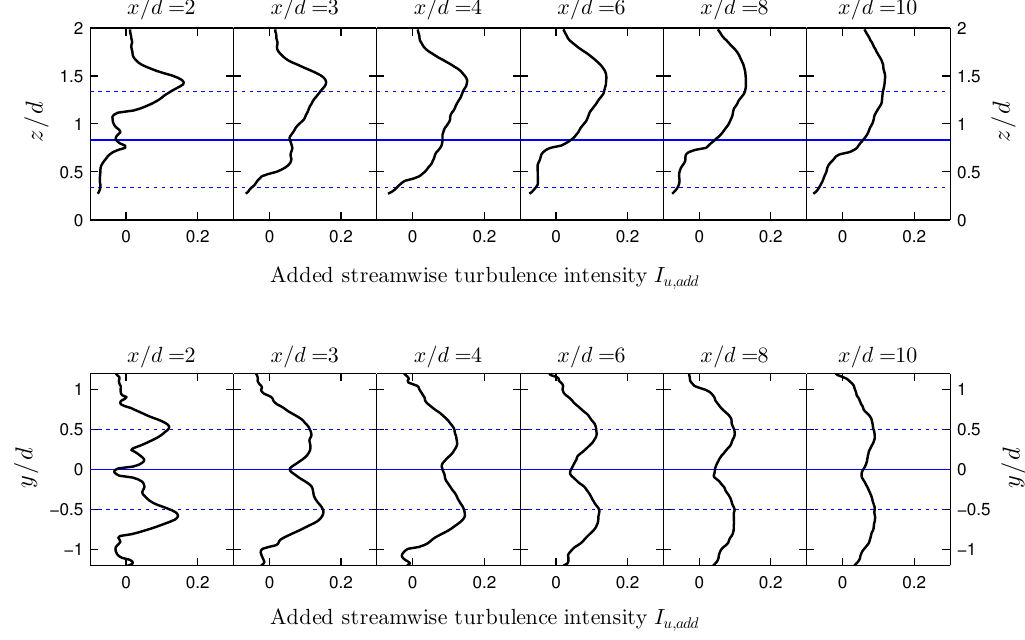
Figure 11. Vertical ( top ) and lateral ( bottom ) profiles of the added streamwise turbulence intensity at hub level at different downstream locations. Blue solid lines and blue dashed lines represent the rotor axis and the tip positions,